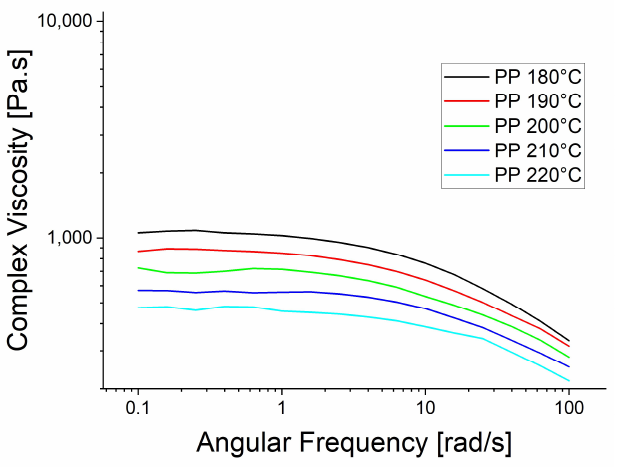
Figure 7. Rheological temperature sweep for PP.